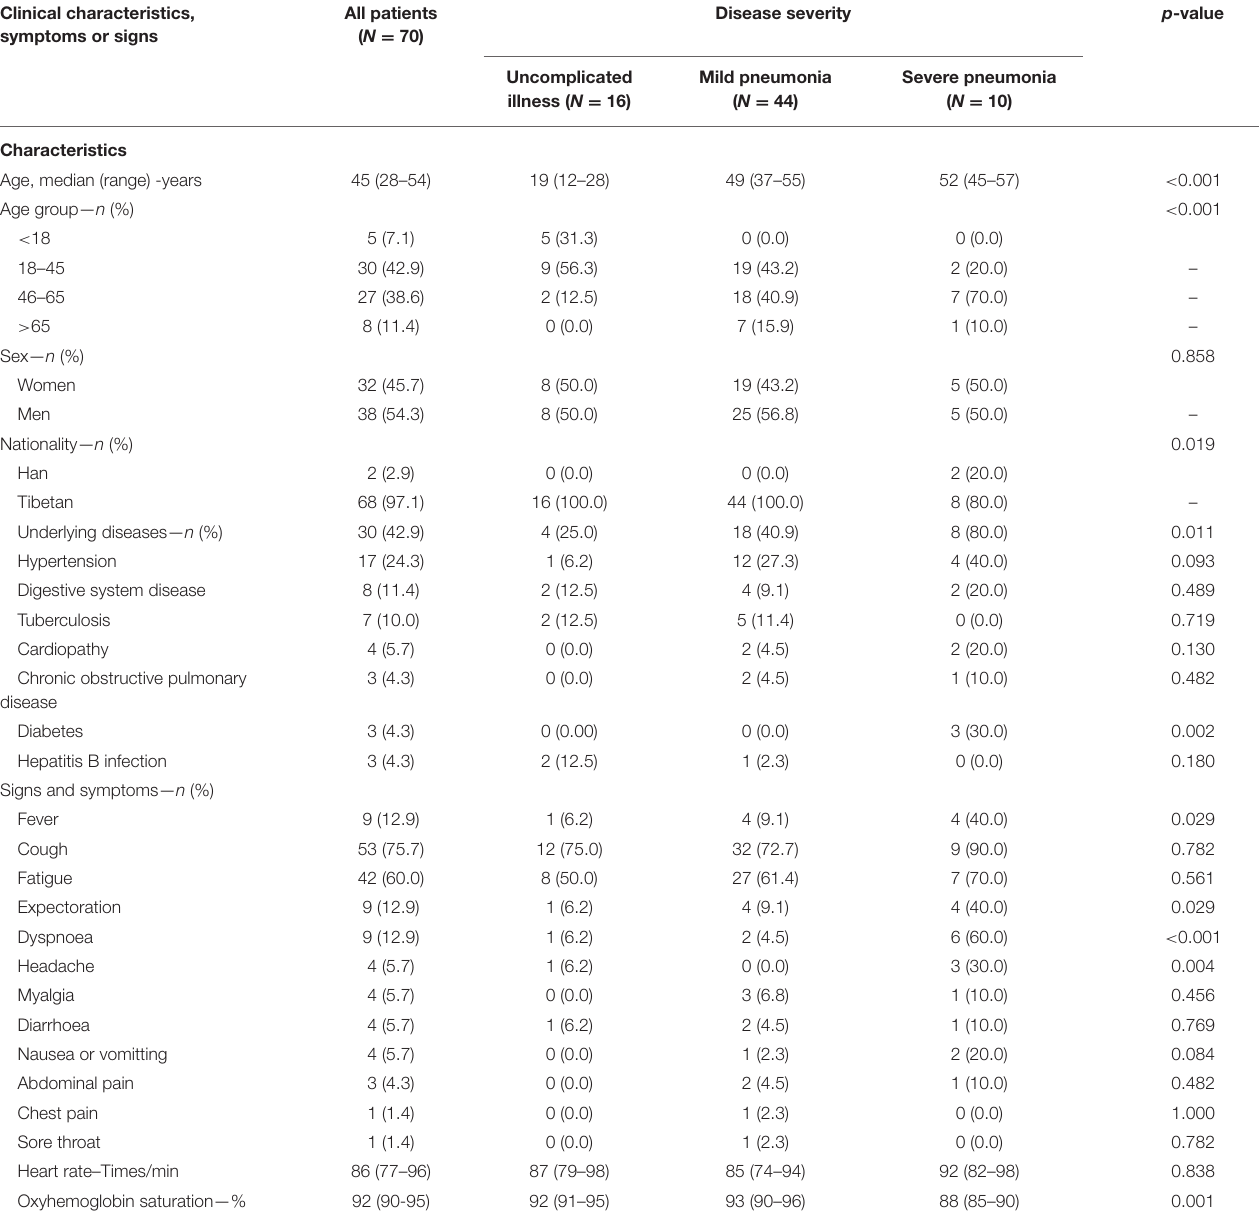
TABLE 2 | Clinical characteristics of 70 patients with COVID-19. Clinical characteristics, symptoms or